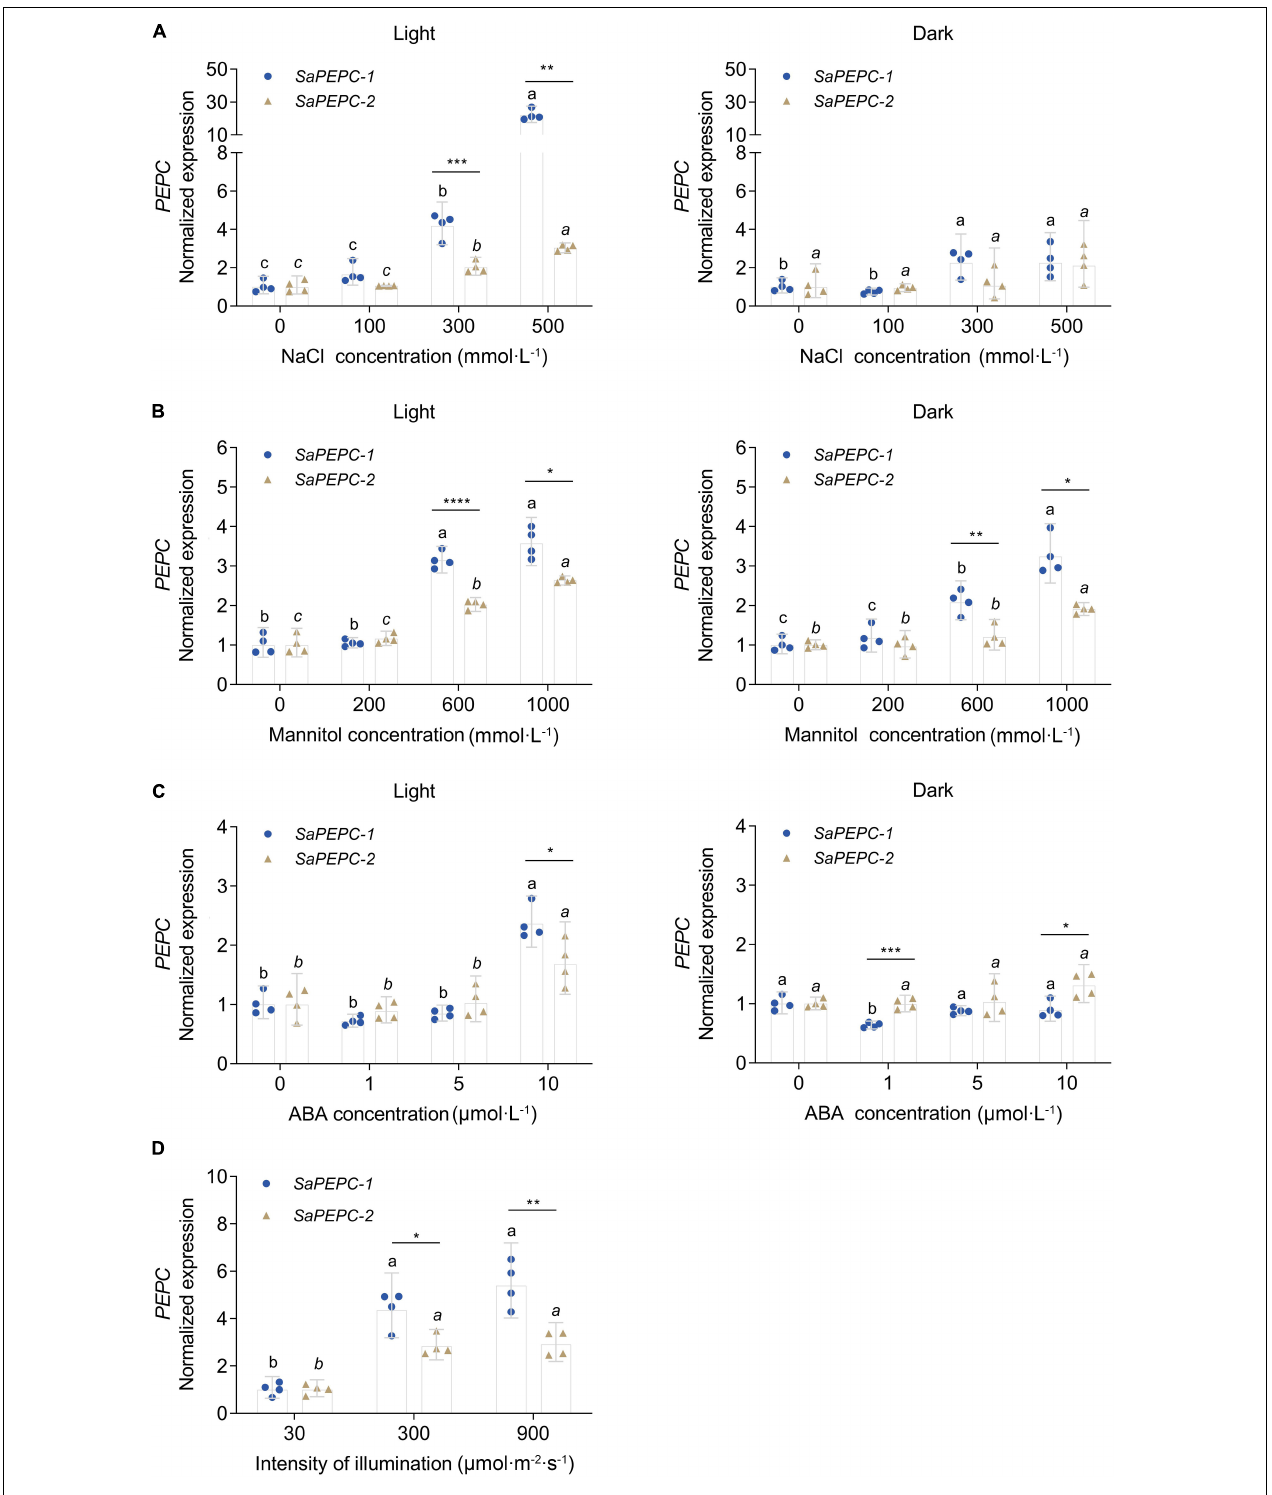
FIGURE 8 | Relative expression of two SaPEPC genes under different light intensity and abiotic stresses. (A–C) Salt, drought, ABA stresses under light and darkness; (D) Treatment under different light intensity. Different lowercase letters indicate a significant difference of the same gene at different concentrations (conc.) or illumination; *, **, ***, ****: Indicate a significant difference between SaPEPC-1 and SaPEPC-2 at the same concentration or illumination at 0.05, 0.01, 0.001, 0.0001 level, respectively. Values are geometric mean ± 95% CI of four biological replicates.